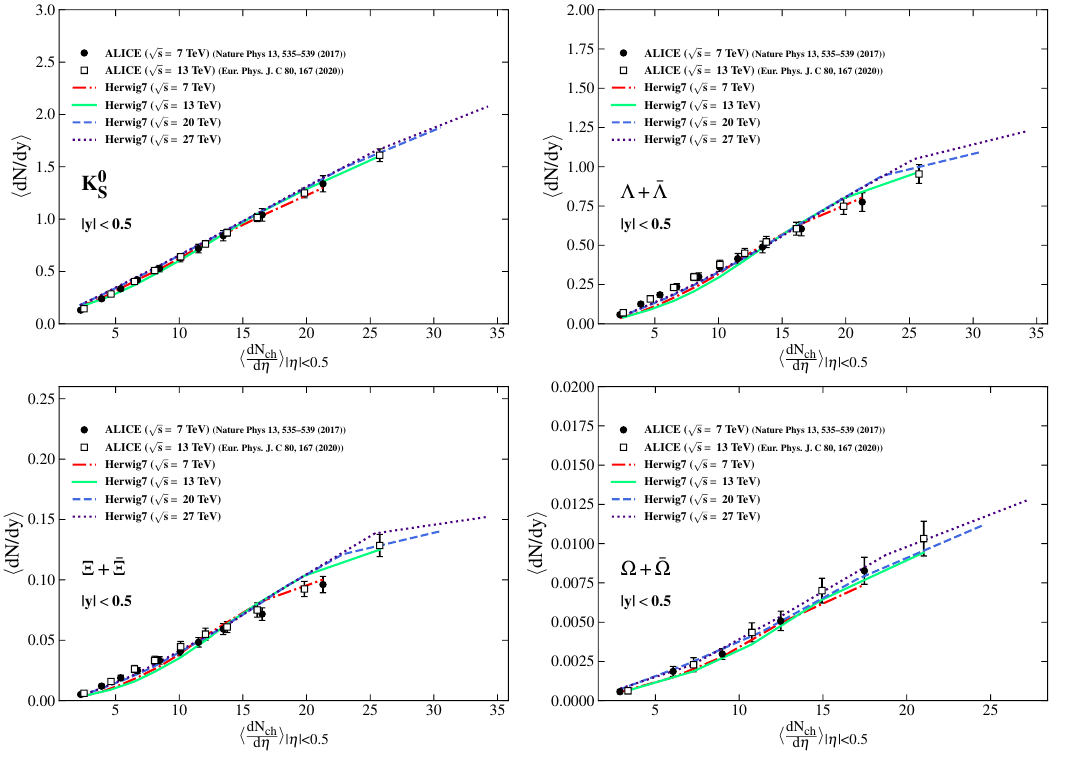
< 0.5 dN ch / d η y measured in (cid:104) (cid:105) | |